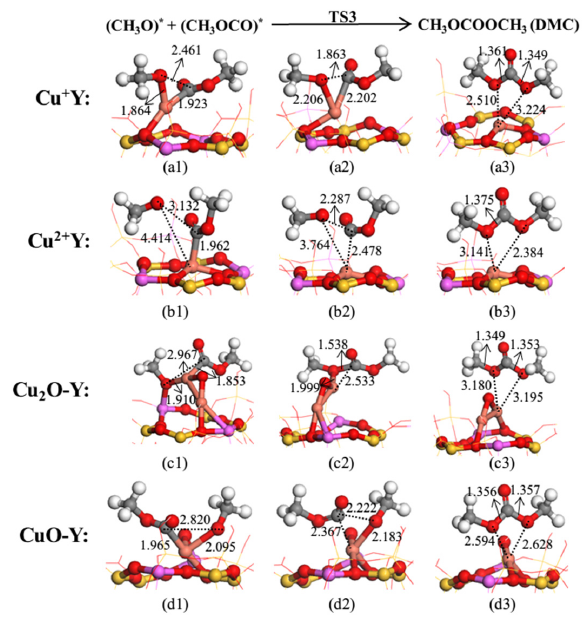
Figure 7. The structures of reactants, products and transition states on Cu + Y, Cu 2+ Y, Cu 2 O-Y and CuO-Y zeolite for the formation of DMC via path I (unit: Å). ( a1 ) (CH 3 O) * /(CH 3 OCO) * on Cu + Y, ( a2 ) TS3 on Cu + Y, ( a3 ) DMC on Cu + Y, ( b1 ) (CH 3 O) * /(CH 3 OCO) * on Cu 2+ Y, ( b2 ) TS3 on Cu 2+ Y, ( b3 ) DMC on Cu 2+ Y, ( c1 ) (CH 3 O) * /(CH 3 OCO) * on Cu 2 O-Y, ( c2 ) TS3 on Cu 2 O-Y, ( c3 ) DMC on Cu 2 O-Y, ( d1 ) (CH 3 O) * /(CH 3 OCO) * on CuO-Y, ( d2 ) TS3 on CuO-Y and ( d3 ) DMC on CuO-Y. See Figure 4 for the color coding.